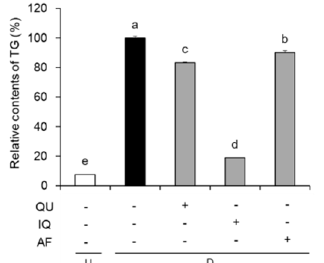
Figure 2. E ff ects of flavonoids from Acer okamotoanum on cell di ff erentiation in di ff erentiated 3T3-L1 cells. Adipocyte di ff erentiation was induced by treatment with 3-isobutyl-1-methylxanthine, dexamethasone, and insulin (MDI) media in the absence or presence of flavonoids from A. okamotoanum during 2 days. The MDI media was then replaced with insulin media, and it was changed four times for every 2 days. The cells were confirmed by light microscopy (magnification, × 100) ( A ). Cells were fixed and stained with Oil Red O staining to visualize the lipid droplets by light microscopy (magnification, × 100) ( B ). Normal group indicates non-di ff erentiated cells, whereas control group indicates the di ff erentiated cells by treatment of MDI media. QU: Quercitrin; IQ: Isoquercitrin; AF: Afzelin.